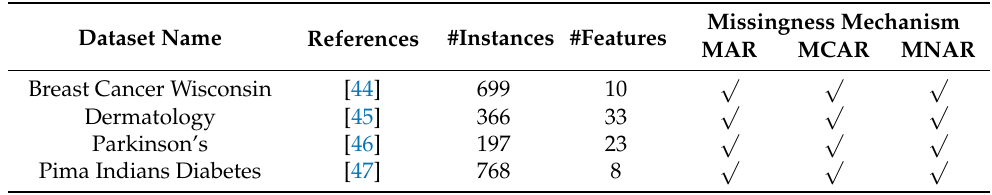
Table 1. The fundamental specifications of the used